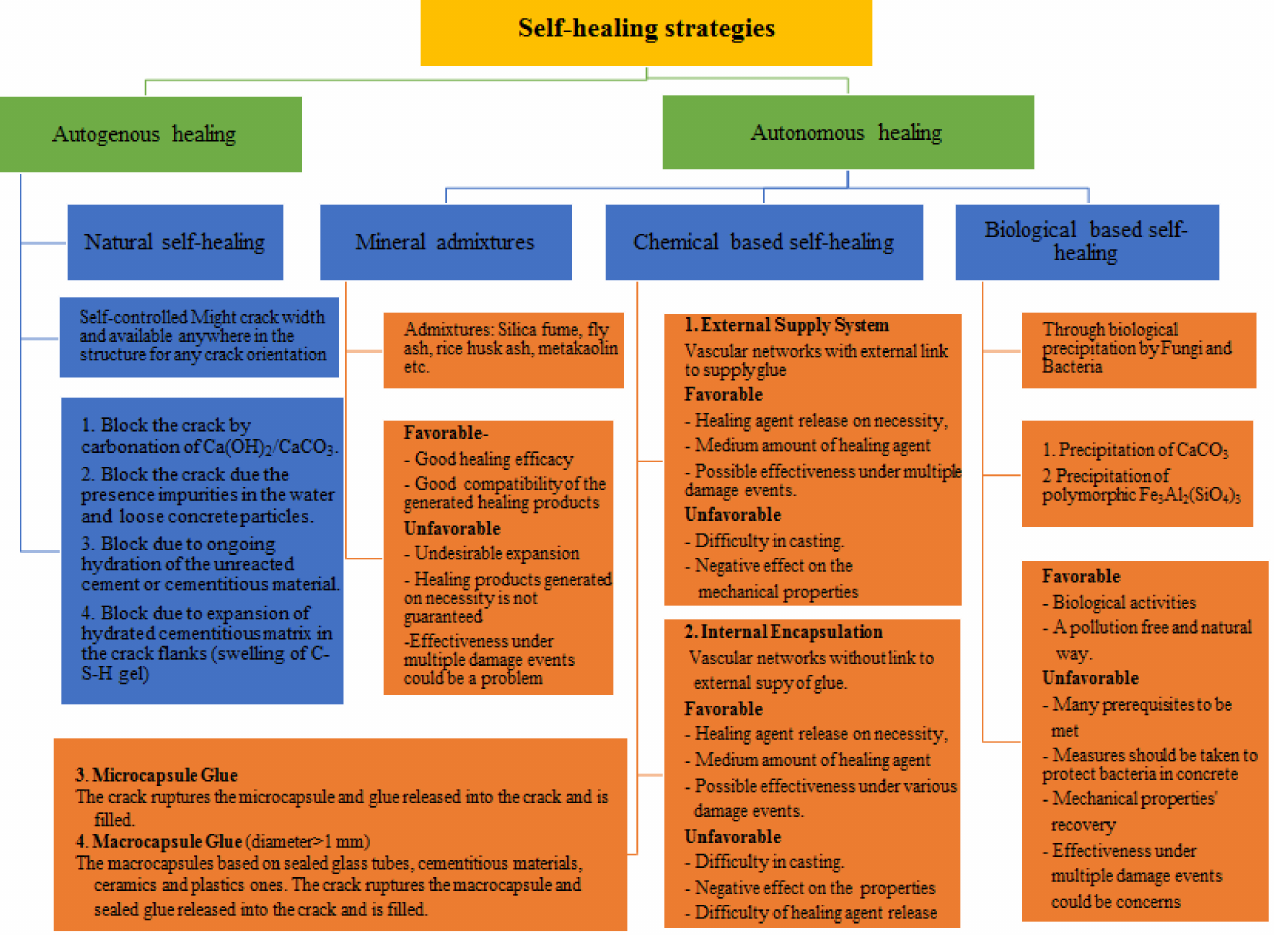
Figure 2. Strategies of self-healing phenomenon for concrete (Adapted with permission from IOP